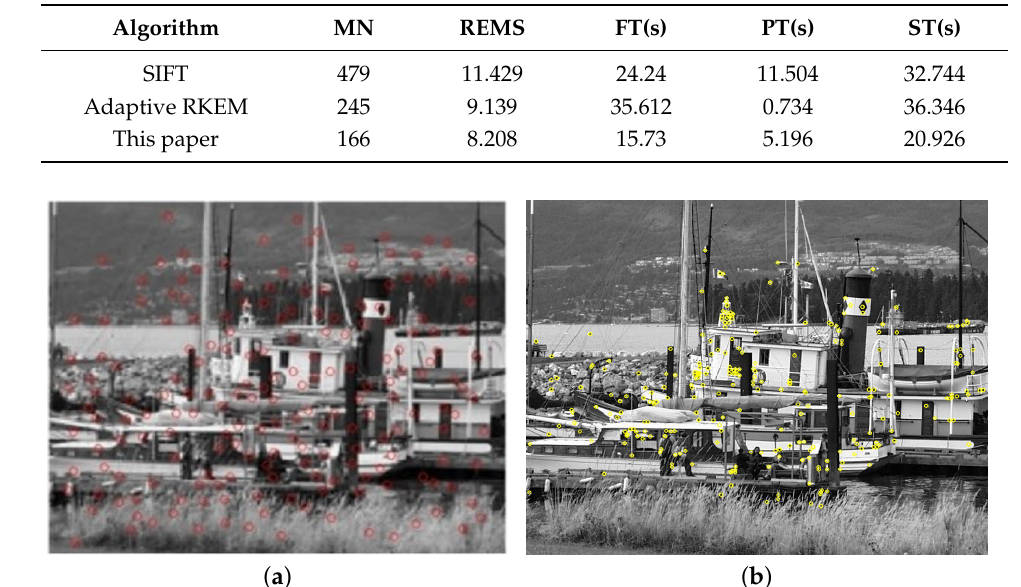
Figure 14. Matching results of images with different affine distortions. ( a ) The adaptive RKEM algorithm; ( b ) The algorithm in this paper. Table 3. Comparison of matching results of different affine distorted images.